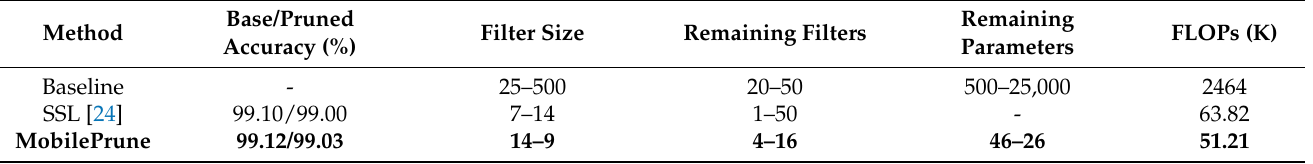
Table A2. Results about learning filter shapes in LeNet-5. (We highlight our MobilePrune results).